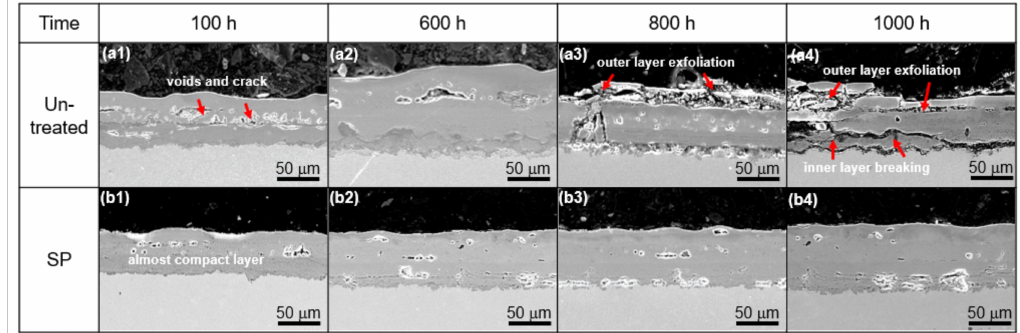
Figure 5. Cross-sectional SEM images of oxide scale after steam exposure of for various durations: ( a1 – a4 ) for untreated and ( b1 – b4 ) for shot peened